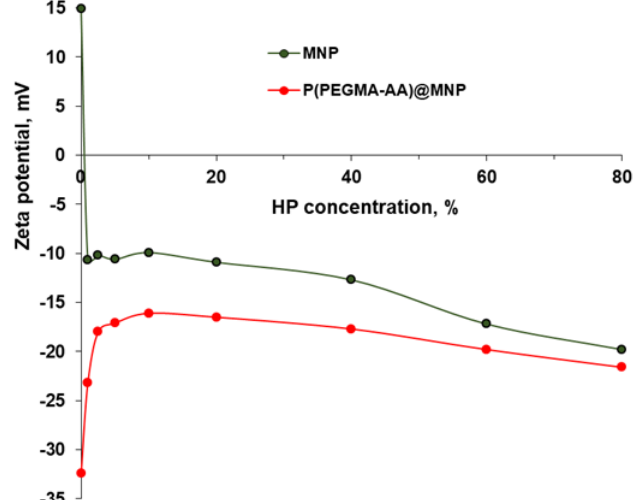
Figure 11. Changes in the electrokinetic potential values of naked and P(PEGMA-AA)-coated MNPs in the course of protein corona formation in HP solutions prepared with Tris-buffered saline solution, as measured at 20 h after the MNP-HP dispersion